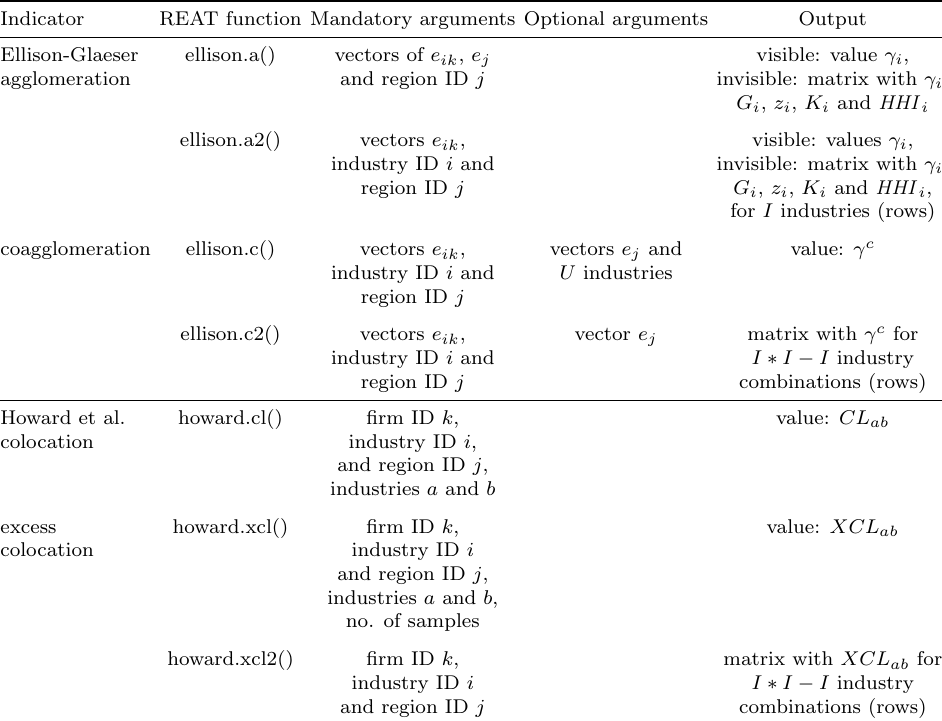
Table 8: REAT functions for agglomeration and coagglomeration using firm data